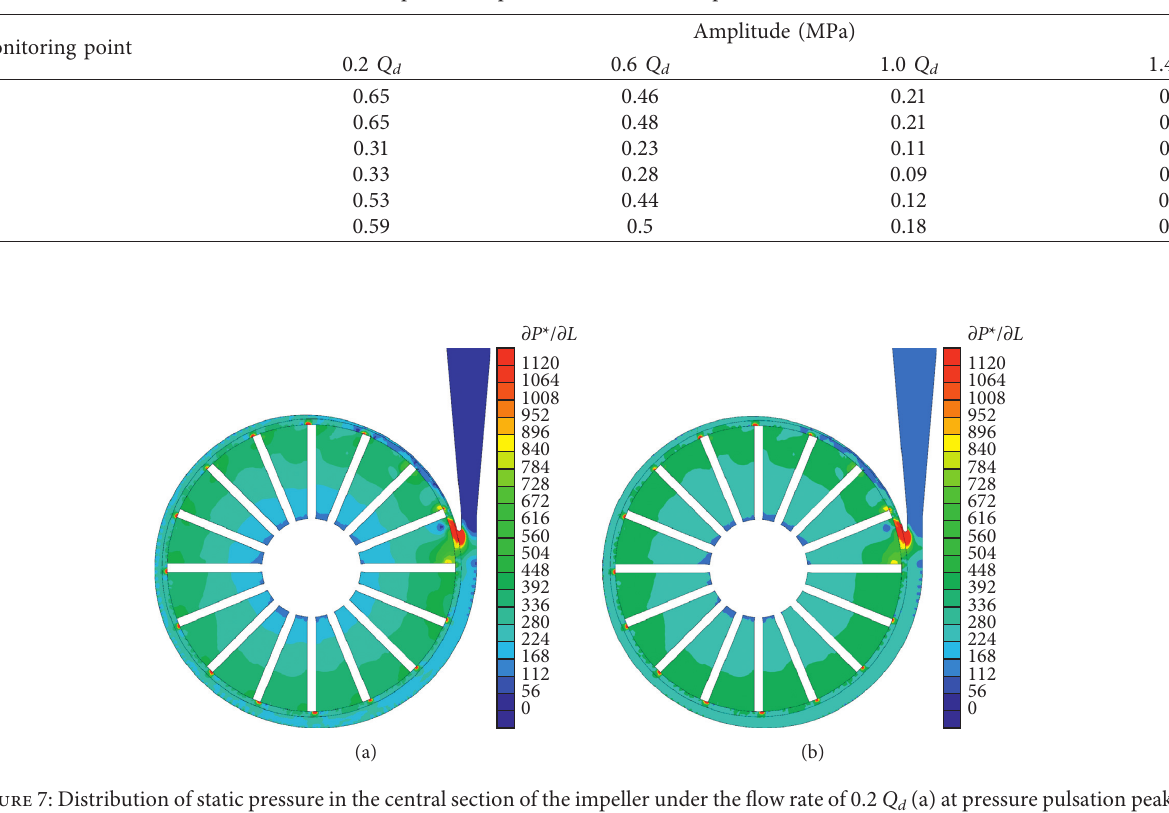
d (a) at pressure pulsation peak and